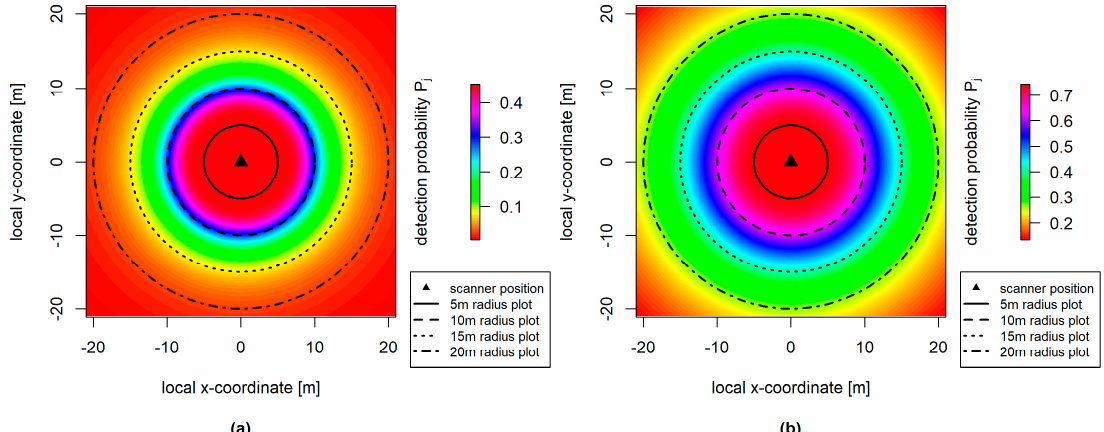
Figure 3. Distance-dependent detection probabilities P j of single-scan terrestrial laser scanning (TLS) for both strata. Cell size of the raster is 1 cm × 1 cm. ( a ) Small trees (5 cm ≤ dbh < 20 cm) and ( b ) large trees (dbh ≥ 20 cm).